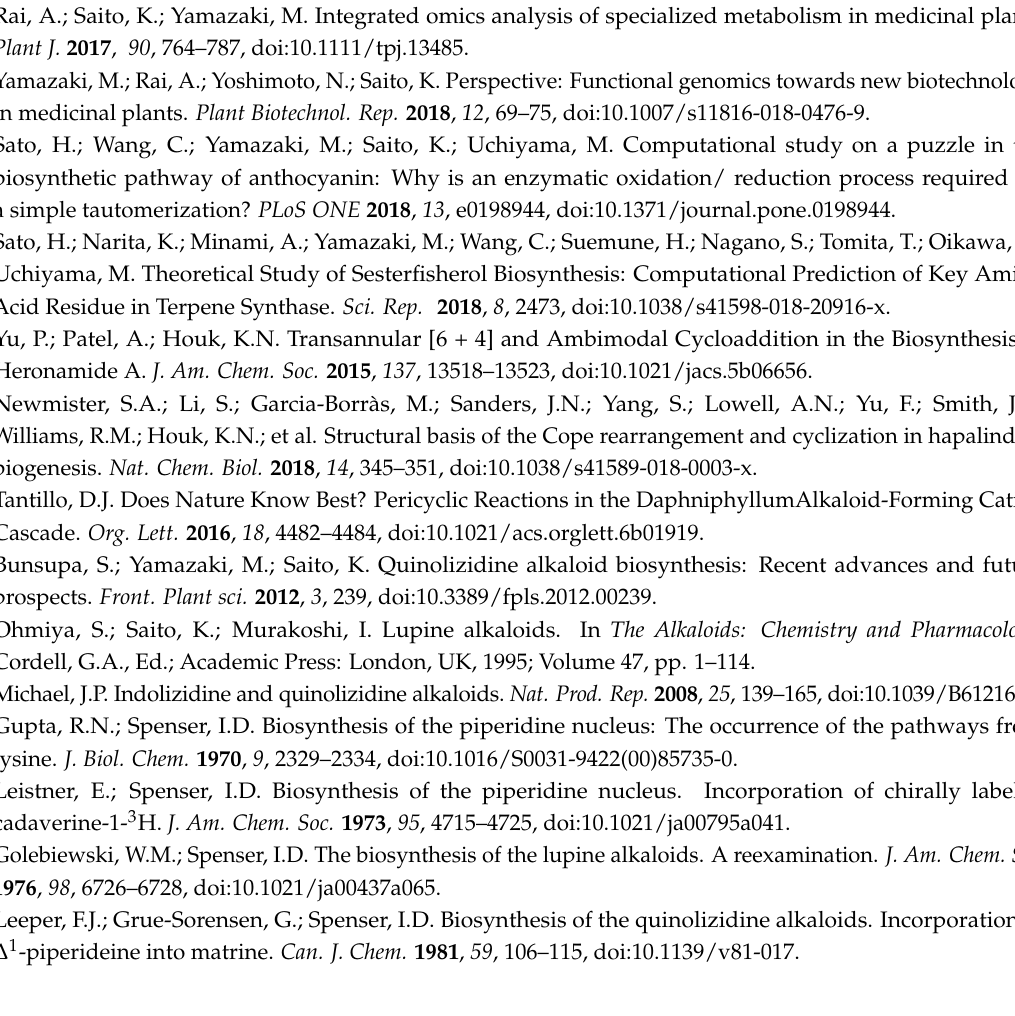
Figure S1: Computed energy profile for (S,S)-piperideine dimer formation under neutral conditions, Figure S2: Computed energy profile for (R,R)-piperideine dimer formation under neutral conditions, Figure S3: Computed energy profiles for ∆ 1 -piperideine dimerization reaction under neutral